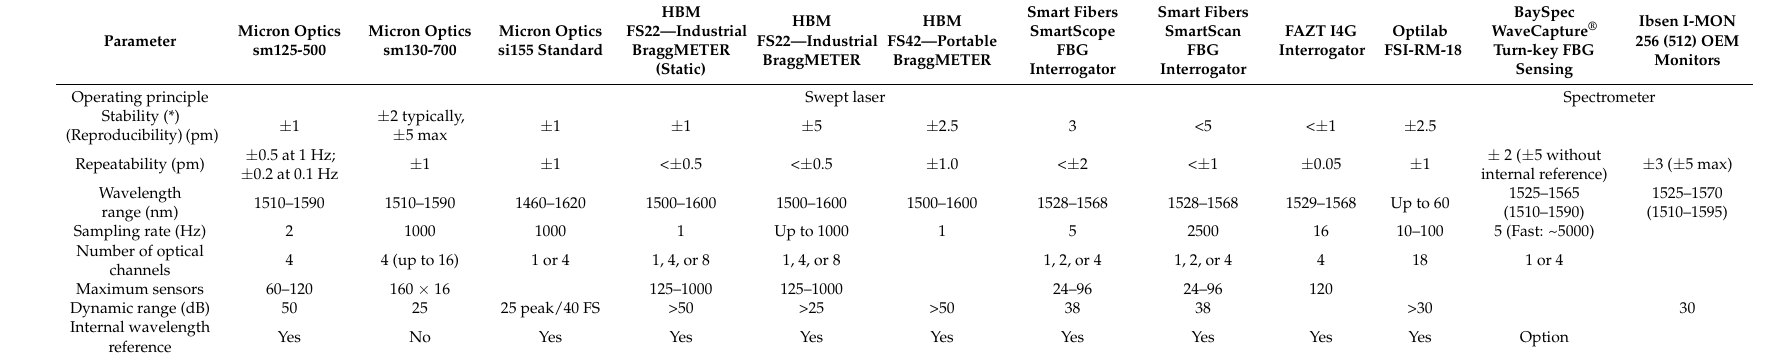
Table 1. Specifications for some commercially available interrogators in the 1550-nm